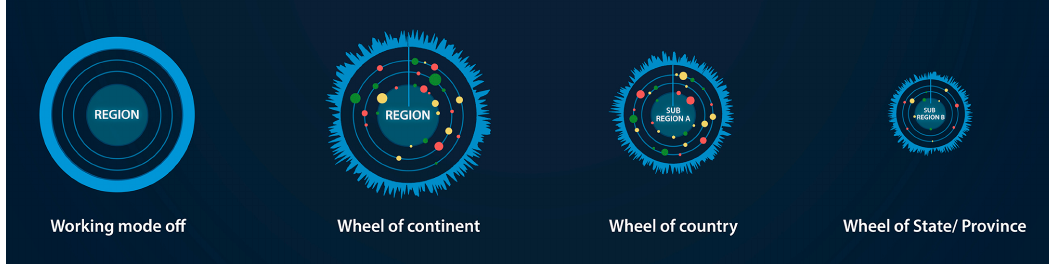
Figure 4 . SolarWheels of different hierarchical scales. Figure 4. SolarWheels of different hierarchical